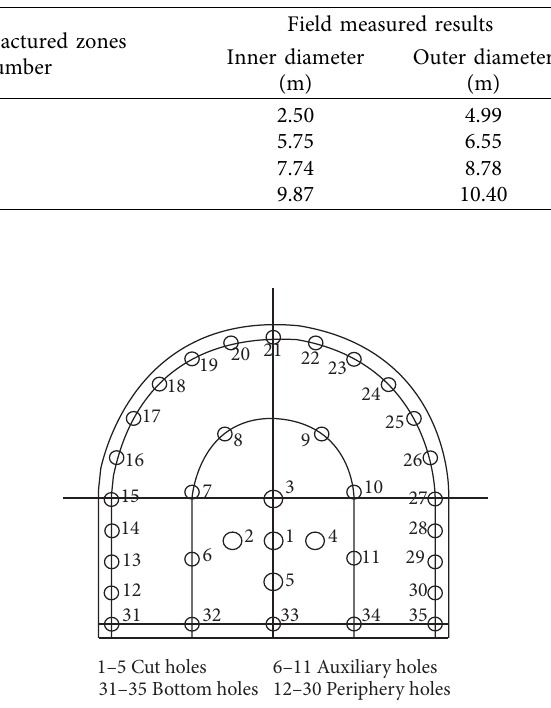
Figure 12: The schematic diagram of blast hole arrangement.